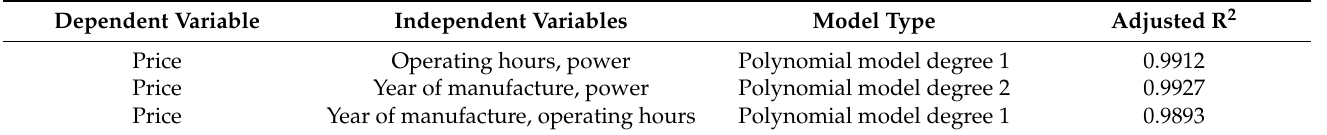
Figure 23. Price vs. operating hours and year of manufacture for second-hand tractors. Table 10. Summary of results with the whole dataset of second-hand tractors, taking variables 2 by 2.